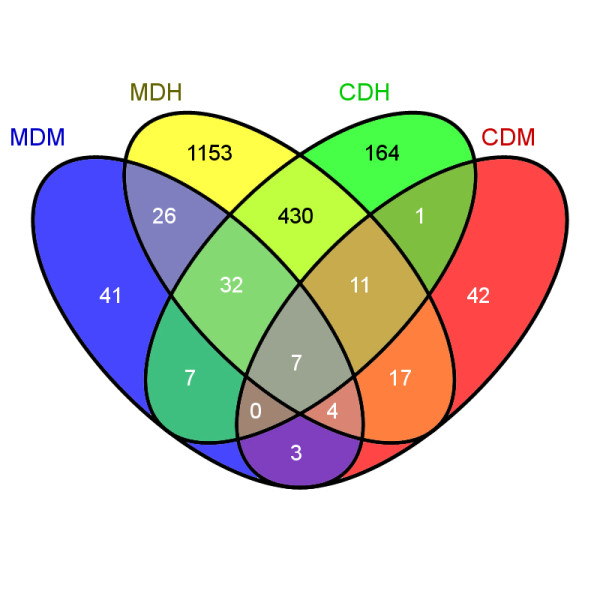
Venn diagram. Number of transcripts significantly differentially expressed in Atlantic cod larvae exposed to chemically or mechanically dispersed oil for 4 days and sampled at 14 days post hatch. MDM = mechanically dispersed oil - medium concentration. MDH = mechanically dispersed oil - high concentration. CDM = chemically dispersed oil - medium concentration. CDH = chemically dispersed oil - high concentration.